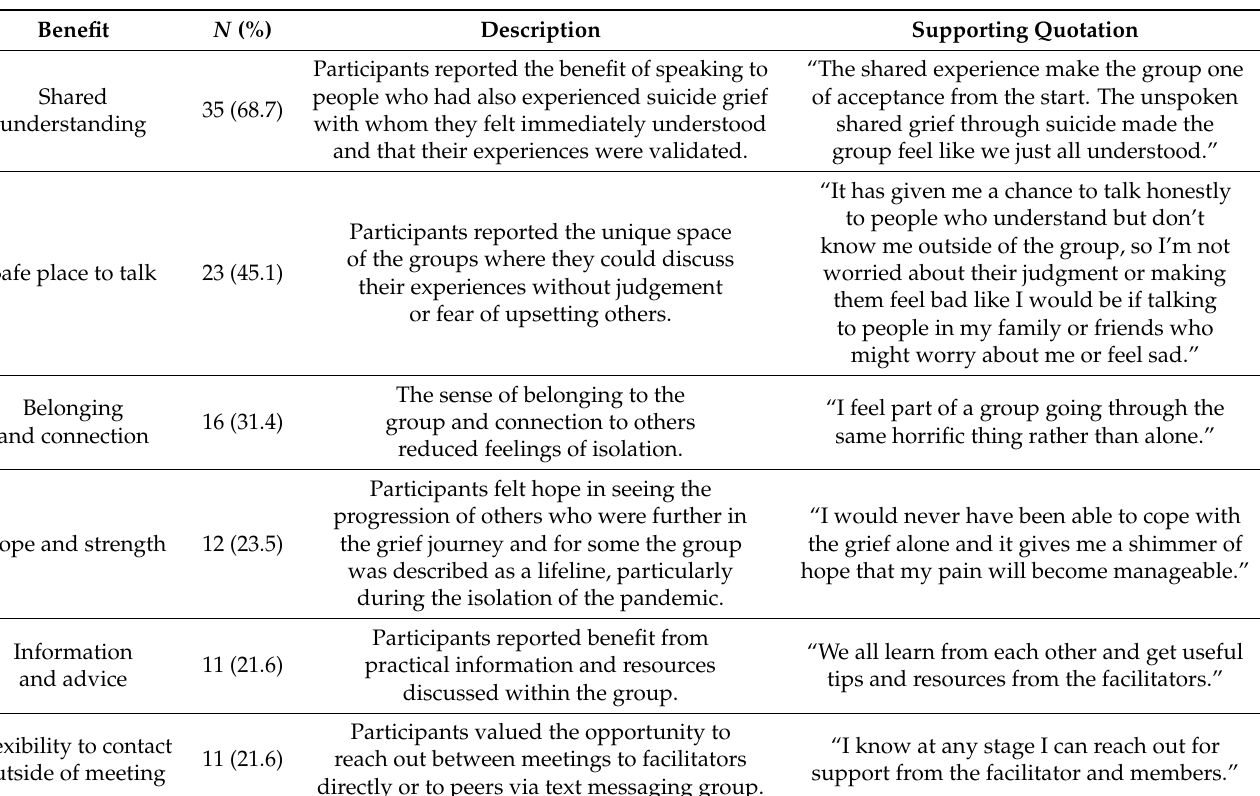
Table 5. Benefits of peer support groups and frequency of participants